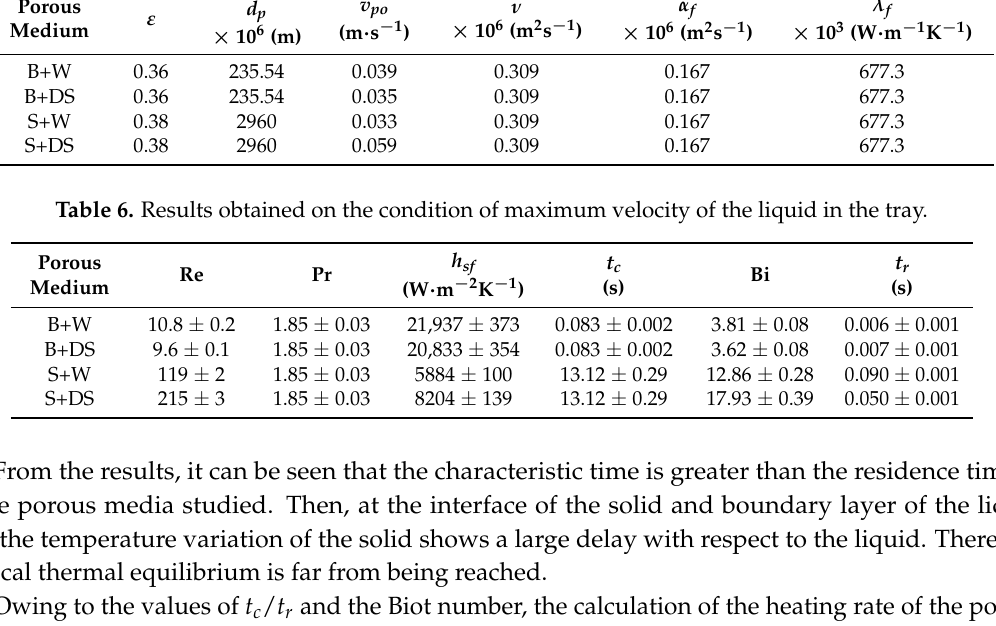
Table 5. Magnitude values.